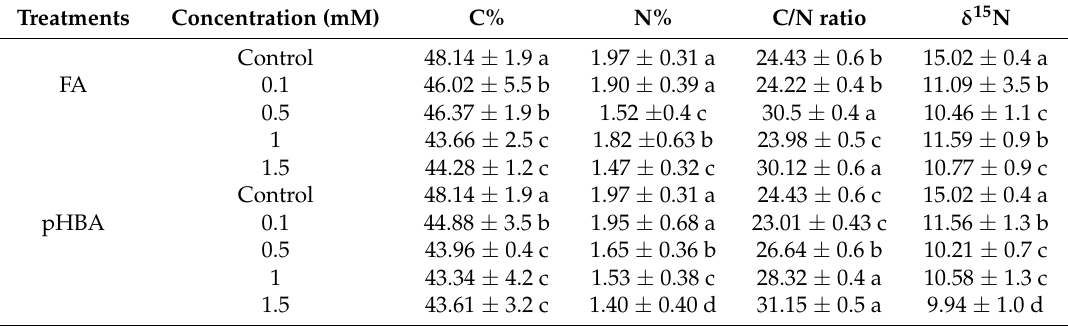
Table 1. Effect of different concentrations of ferulic acid (FA) and p-hydroxybenzoic acid (pHBA) on carbon and nitrogen concentrations and nitrogen isotope composition ( δ 15 N) of Rumex acetosa .